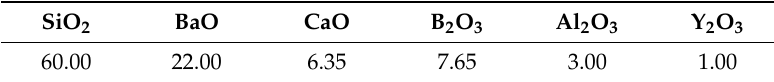
Table 1. Composition (mol%) of HJ28 glass